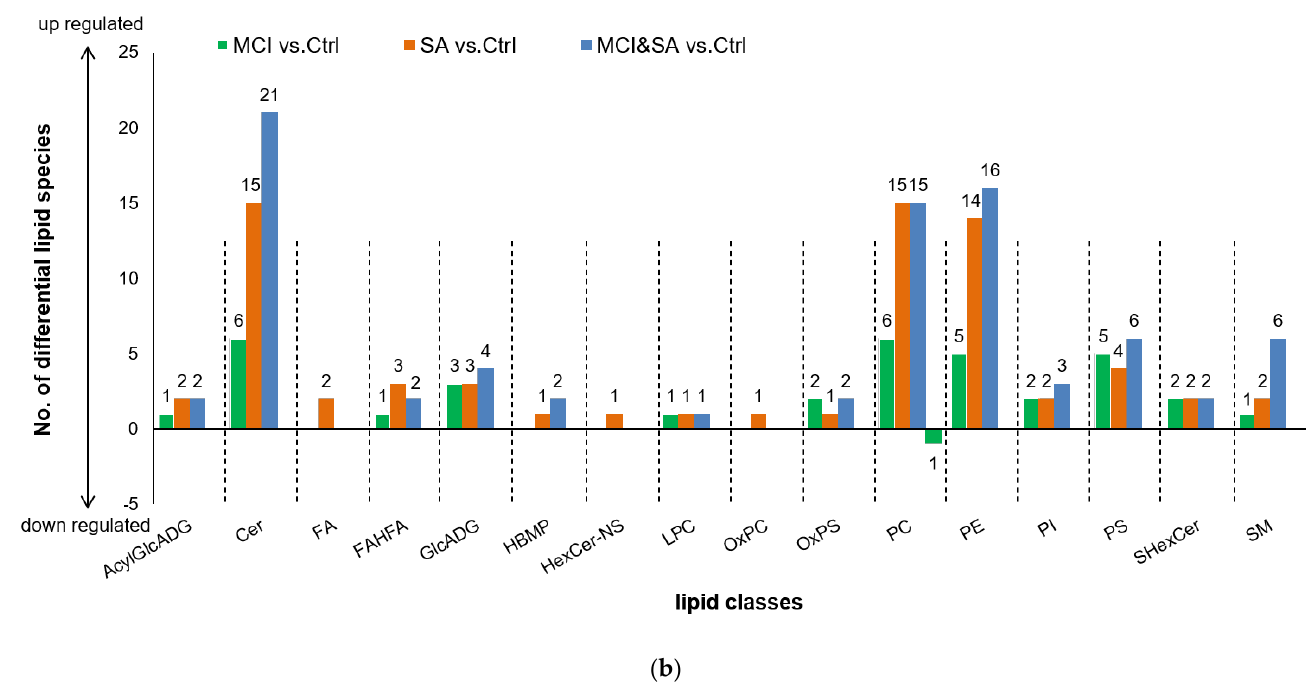
Figure 2. ( 1 ) Number of lipids with significant changes in different comparisons ( VIP > 1, p < 0.05). ( 2 ) Number of differential lipid species according to ( 1 ) in (a) positive and (b) negative ionization mode. CE, cholesteryl ester; Cer, ceramides; DGTS, diacylglyceryltrimethylhomoserine; FA, fatty acids; GlcADG, glucuronosyldiacylglycerol; HexCer, hexosylceramide; LPC, lyso-phosphatidylcholines; PC, phosphatidylcholine; PE, phosphatidylethanolamines; PI, phosphatidylinositol; PS, phosphatidylser- ine; SM, sphingomyelins; TAG,